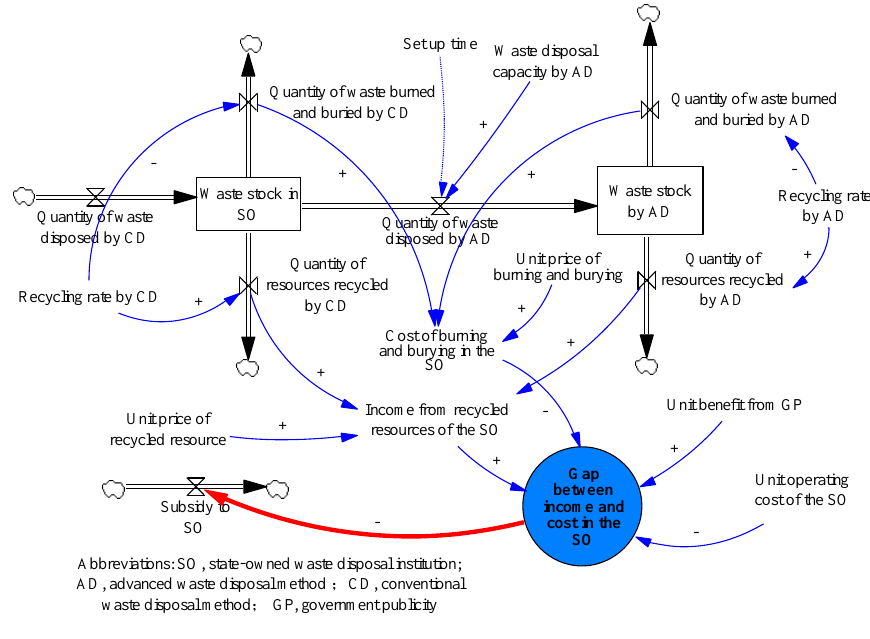
Figure 3. The CLD of SO waste disposal module.